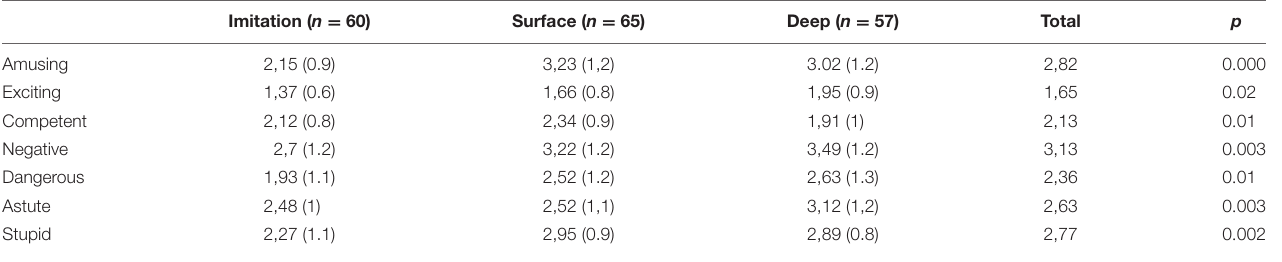
TABLE 2 | Descriptive statistics of Character evaluation (mean and